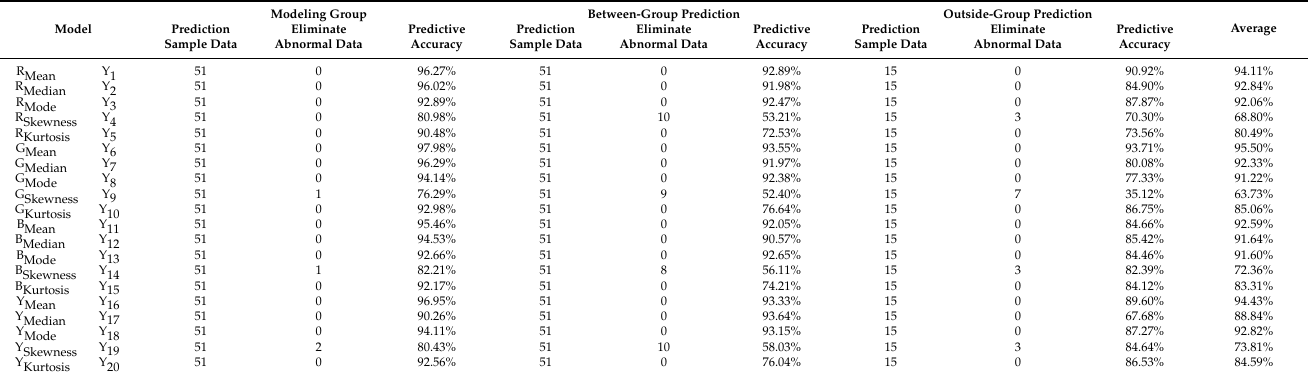
Table 4. Analytical results of prediction accuracy of population canopy color-meteorological response models.